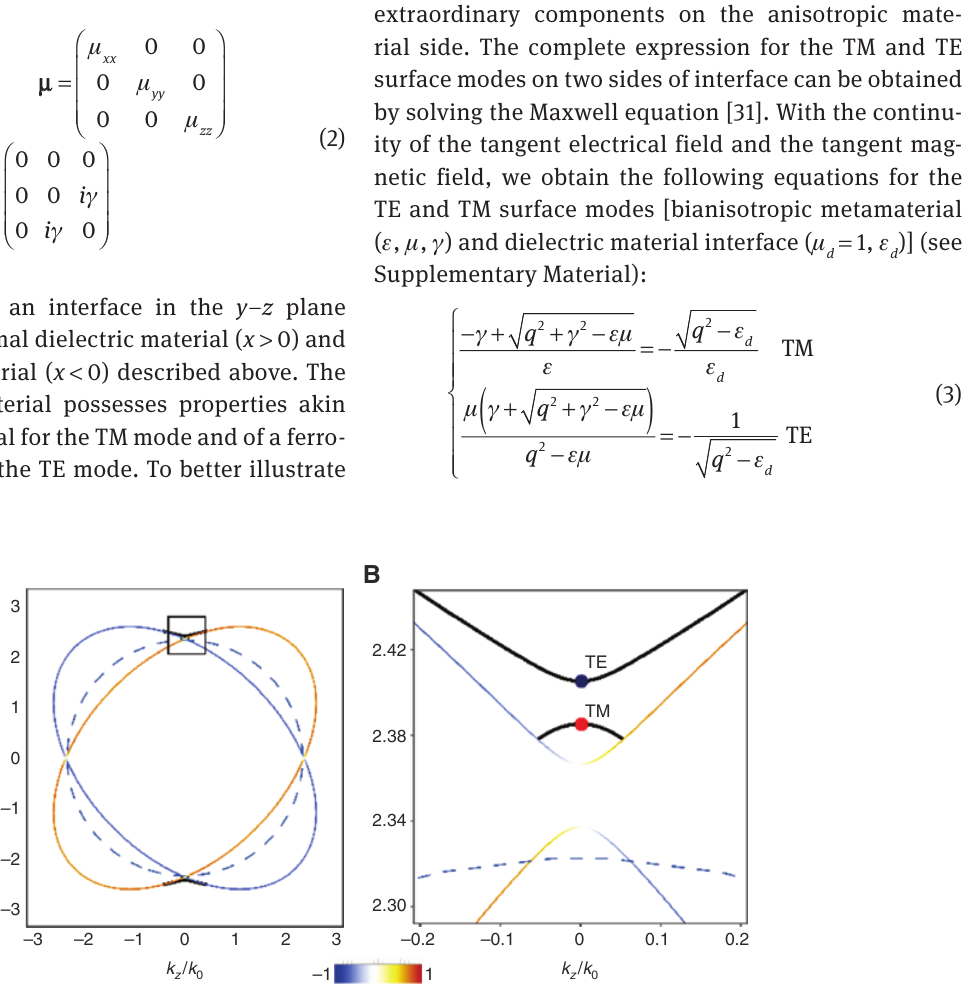
Figure 2: Dispersion of the bulk and surface wave of the bianisotropic metamaterial. (A) Two ellipsoids denoting the two bulk mode EFS of the bianisotropic material with the parameters ε = diag (5.89, 6.79, 6.79), μ = diag (1, 1.13, 1.13), and γ = 1.16 at 8.7 GHz. It color denotes the degree of polarization, as shown in the color bar, with 1 and −1 denoting left-handed and right-handed circular polarization, respectively. The dashed blue line gives the bulk EFS of the dielectric material with permittivity = 5.4. The four black lines in the shape of two hyperbolas illustrate the surface wave existing between the interface of the bianisotropic ε d material and the dielectric material. (B) Enlarged picture of the black dashed rectangle in (A). The highlighted blue and red points denote pure TE and TM surface modes,